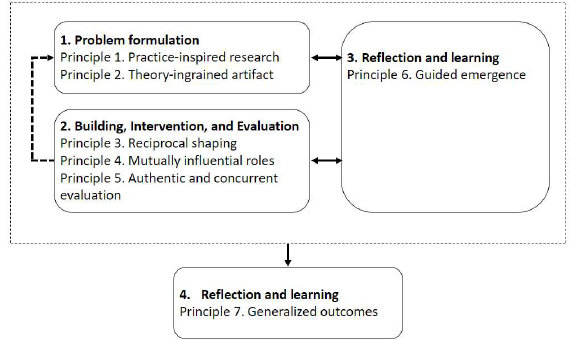
Figure 2. Action design research stages and principles